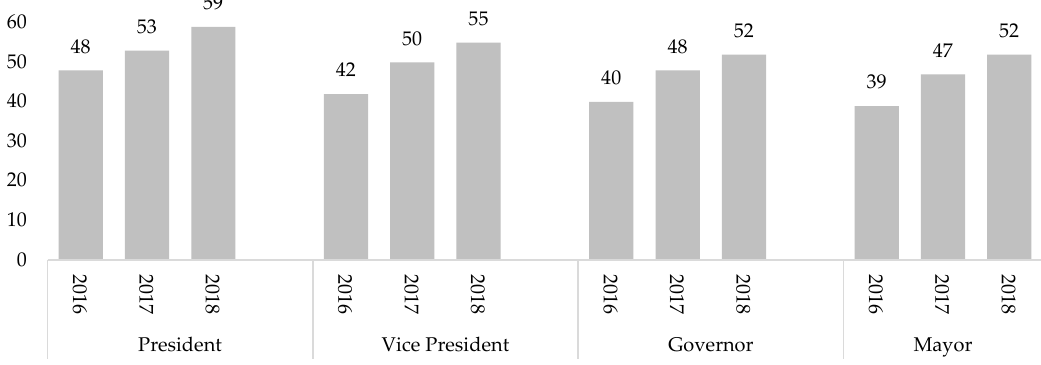
Figure 1. Share of respondents (in %) who would object if a non-Muslim became President, Vice President, Governor, or Mayor. Source: Lembaga Survei Indonesia (2019).